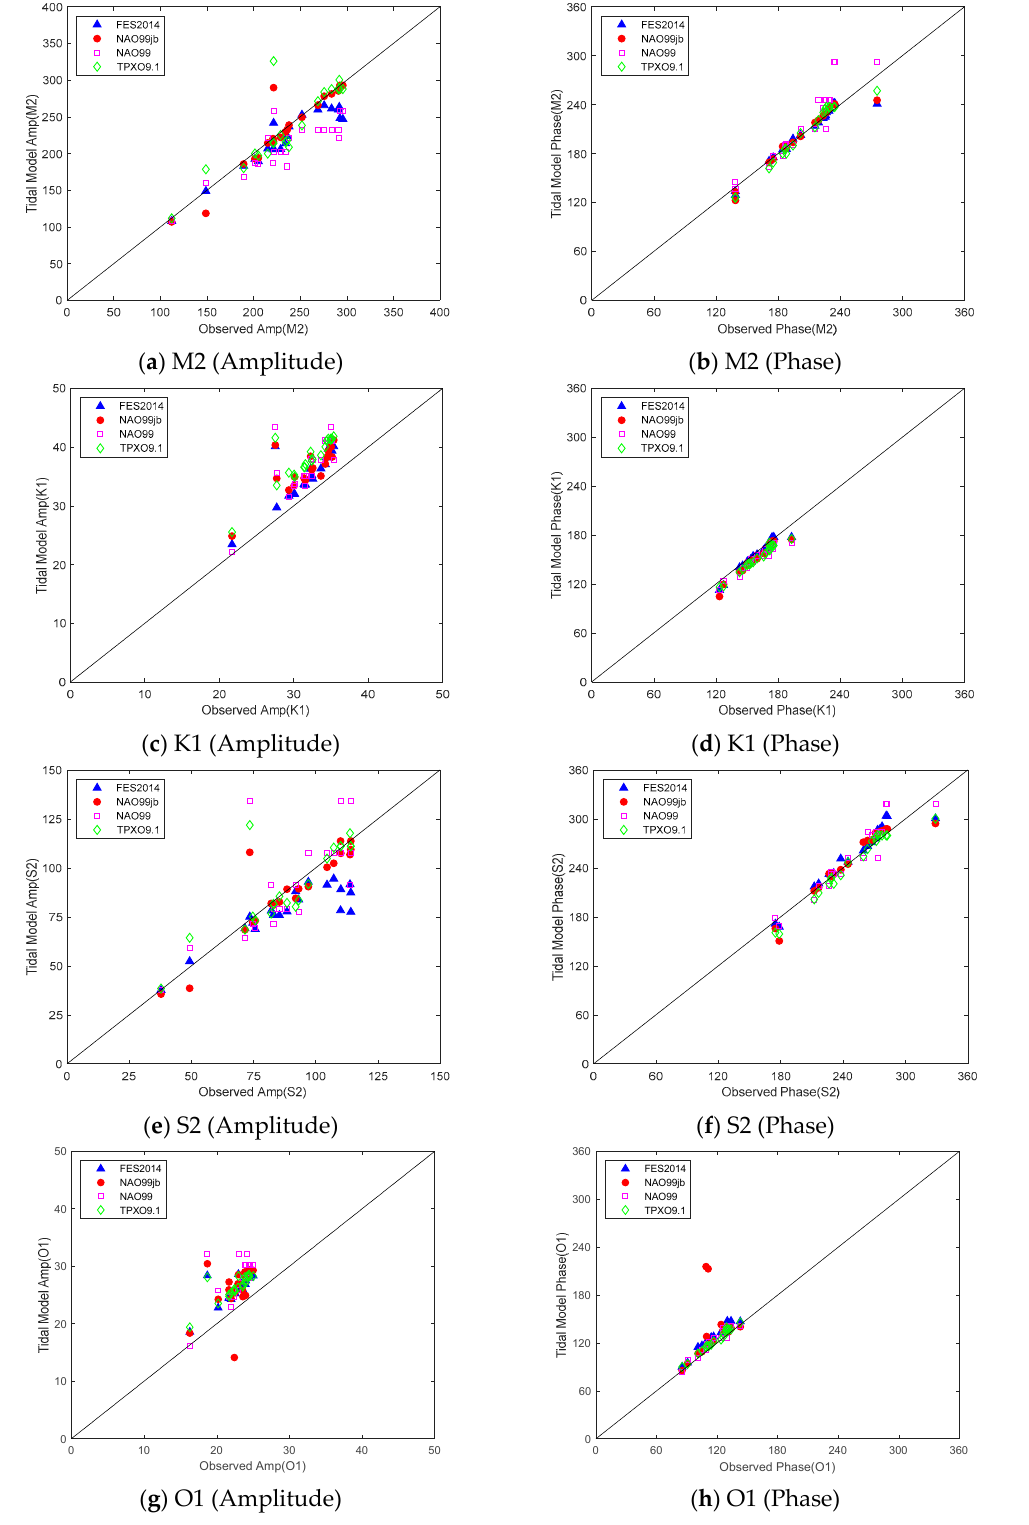
Figure 2. Validation of amplitudes and phases obtained from assimilated tidal models (FES2014, NAO99Jb, NAO99 and TPXO9) against observed data at tidal gauges; ( a ): M2’s amplitude, ( b ): M2’s phase, ( c ): K1’s amplitude, ( d ): K1’s phase, ( e ): S2’s amplitude S2, ( f ): S2’s phase, ( g ): O1’s amplitude, ( h ): O1’s phase.